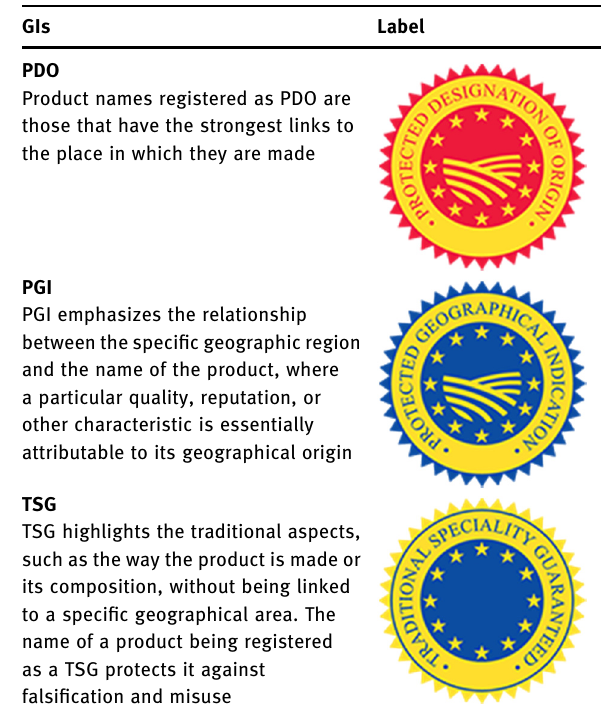
Table 1: Quality certi fi cation schemes in EU quality policy